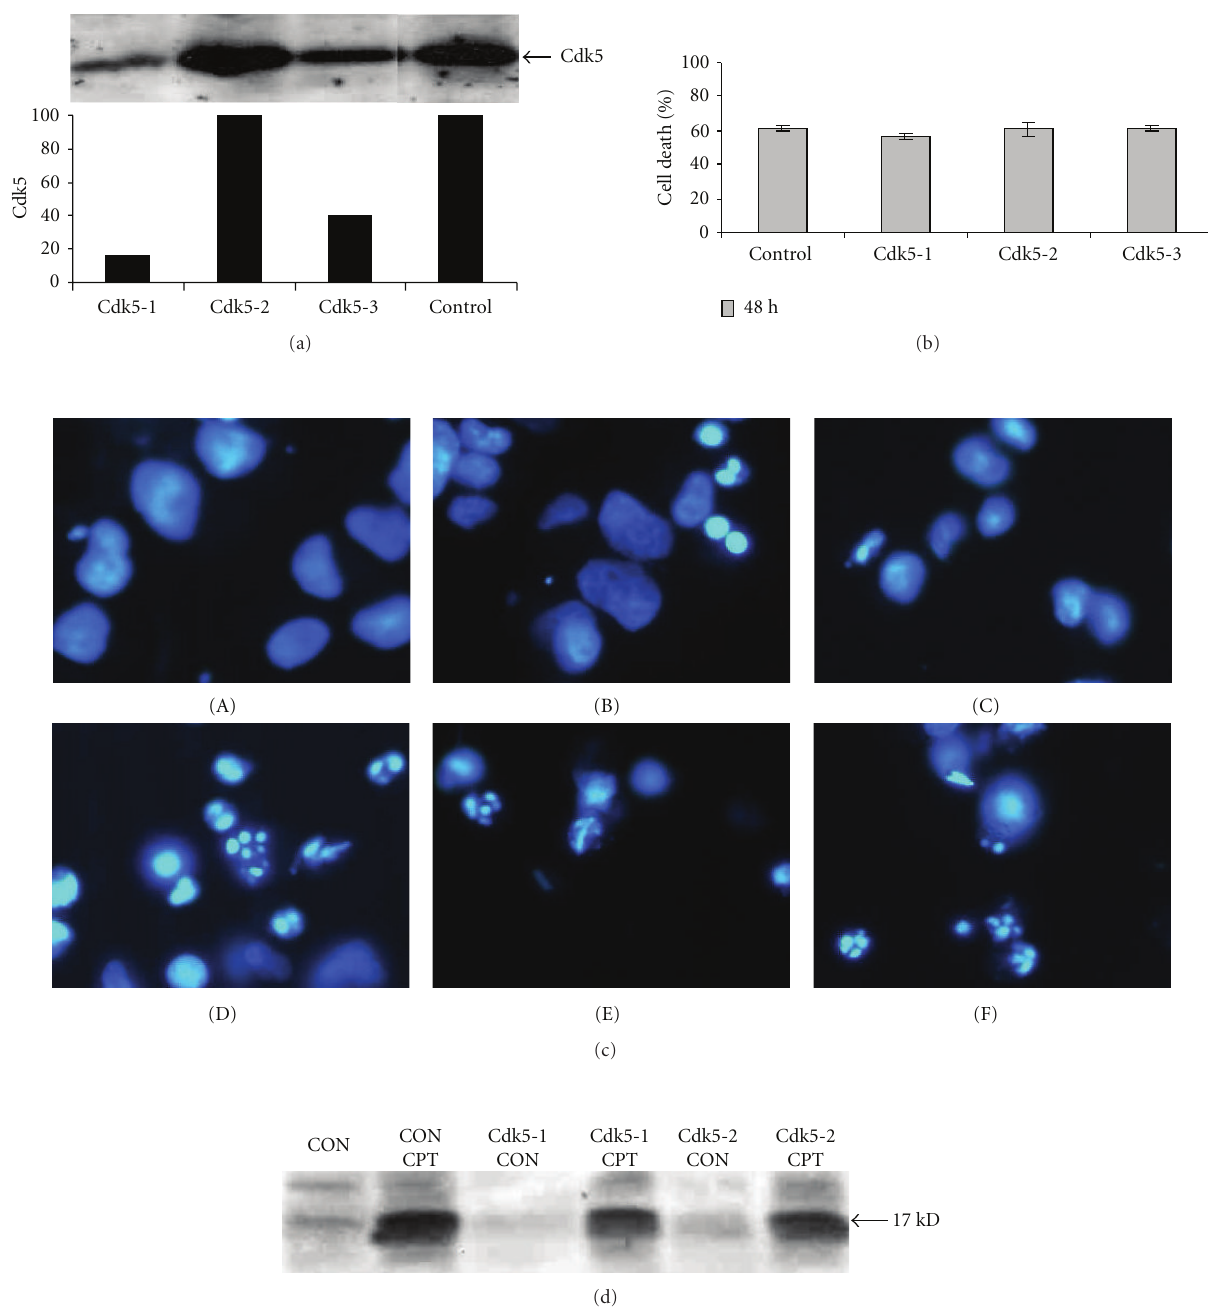
Figure 4: Inhibition of Cdk5 expression does not protect cells from death. (a) COS-7 cells transfected with dsRNA (Cdk5-1, Cdk5-2, Cdk5- 3) were collected and lysed by RIPA bu ff er. Western blot of equal amounts of cell lysates from COS-7 cells showed Cdk5 expression in all cells (A), and the amount of Cdk5 was measured by densitometry (B). dsRNA of Cdk5-1 and Cdk5-3 downregulated Cdk5 expression. (b) COS-7 cells transfected with Cdk5-1, 5-2, or 5-3 dsRNA were treated with 25 μ M CPT for 48 hours, and cell death was measured by trypan blue exclusion. Downregulation of Cdk5 by RNAi did not a ff ect the amount of cell death. The amount of cell death was calculated by subtracting the amount of cell death in untreated control cells. The error bars represent the standard deviation from at least three individual experiments. (c) COS-7 cells treated with 25 μ M CPT for 48 hours were fixed with 4% paraformaldehyde and stained with Hoechst 33 258 dye. Apoptotic cells manifest condensed and fragmented nuclei as is seen in (D), (E), and (F). (A) Control cells; (D) CPT-exposed control cells; (B) cells transfected with Cdk5-1; (E) cells transfected with Cdk5-1 and treated with CPT; (C) cells transfected with Cdk5-2; (F) cells transfected with Cdk5-2 and treated with CPT. The numbers and percent of dead cells were not calculated but appeared to be consistent with the results presented in Figure 4(b). (d) COS-7 cells were incubated with 25 μ M CPT for 48 hours with or without a dsRNA. After 48hours incubation, cells were collected and proteins were extracted. Western blots of cell lysates from cells showed the activation caspase-3 by CPT both in the control cells and transfected